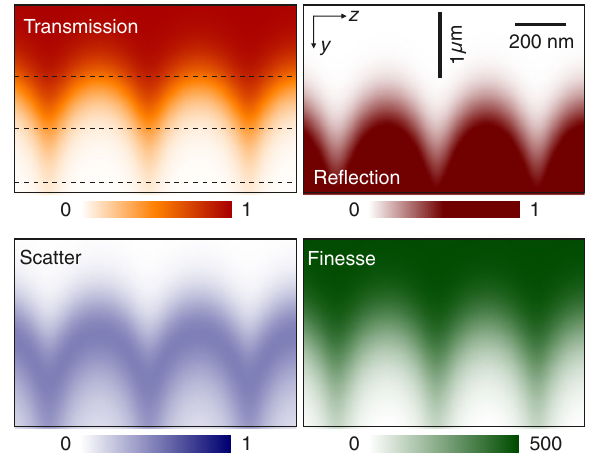
FIG. 16. Typical results of simulations. Same simulations as in Fig. 15 in the vertical YZ plane above the optical axis ( x ¼ 0 ). The optical axis is located at the bottom of the image, and the three dashed lines correspond to the NW elevations in the previous figure.